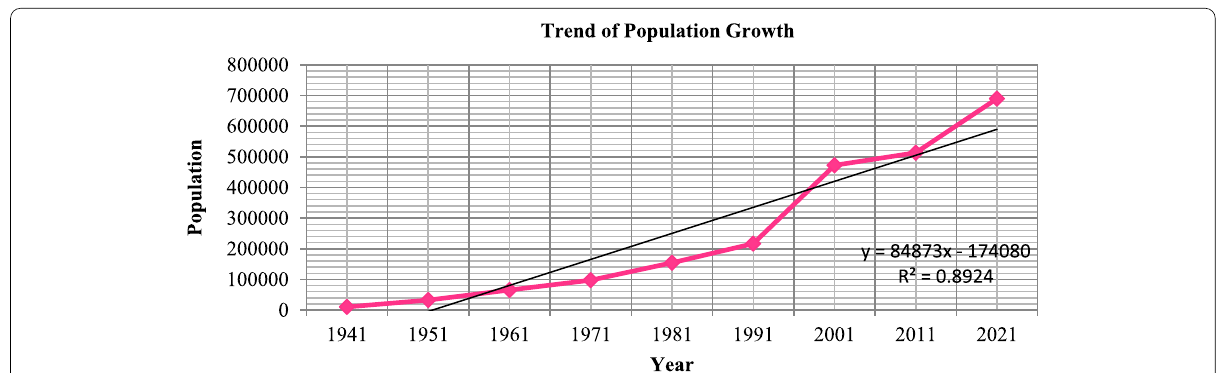
Fig. 1 Trend of Population Growth in Siliguri Municipal Corporation